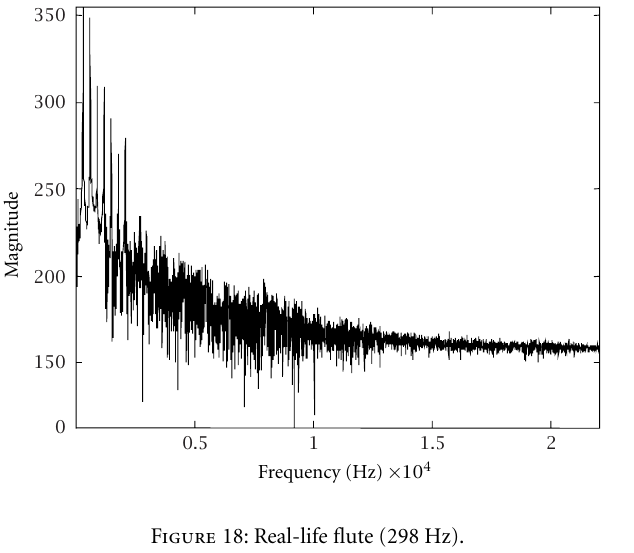
Figure 18: Real-life flute (298 Hz).